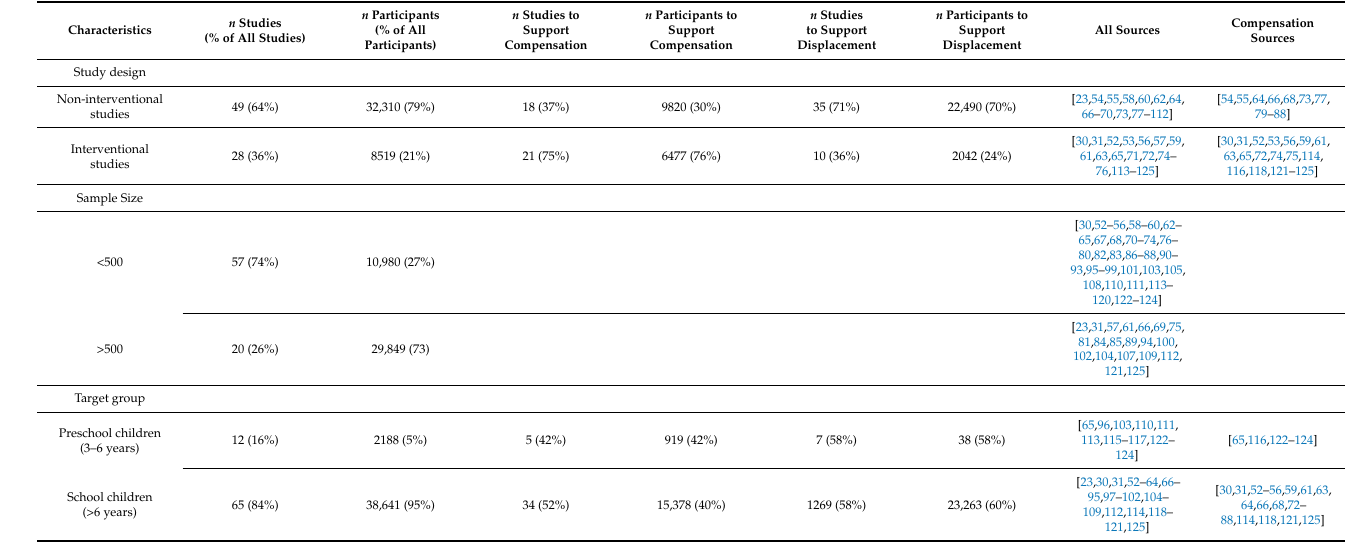
Table 2. Characteristics and compensation or displacement voting of all included